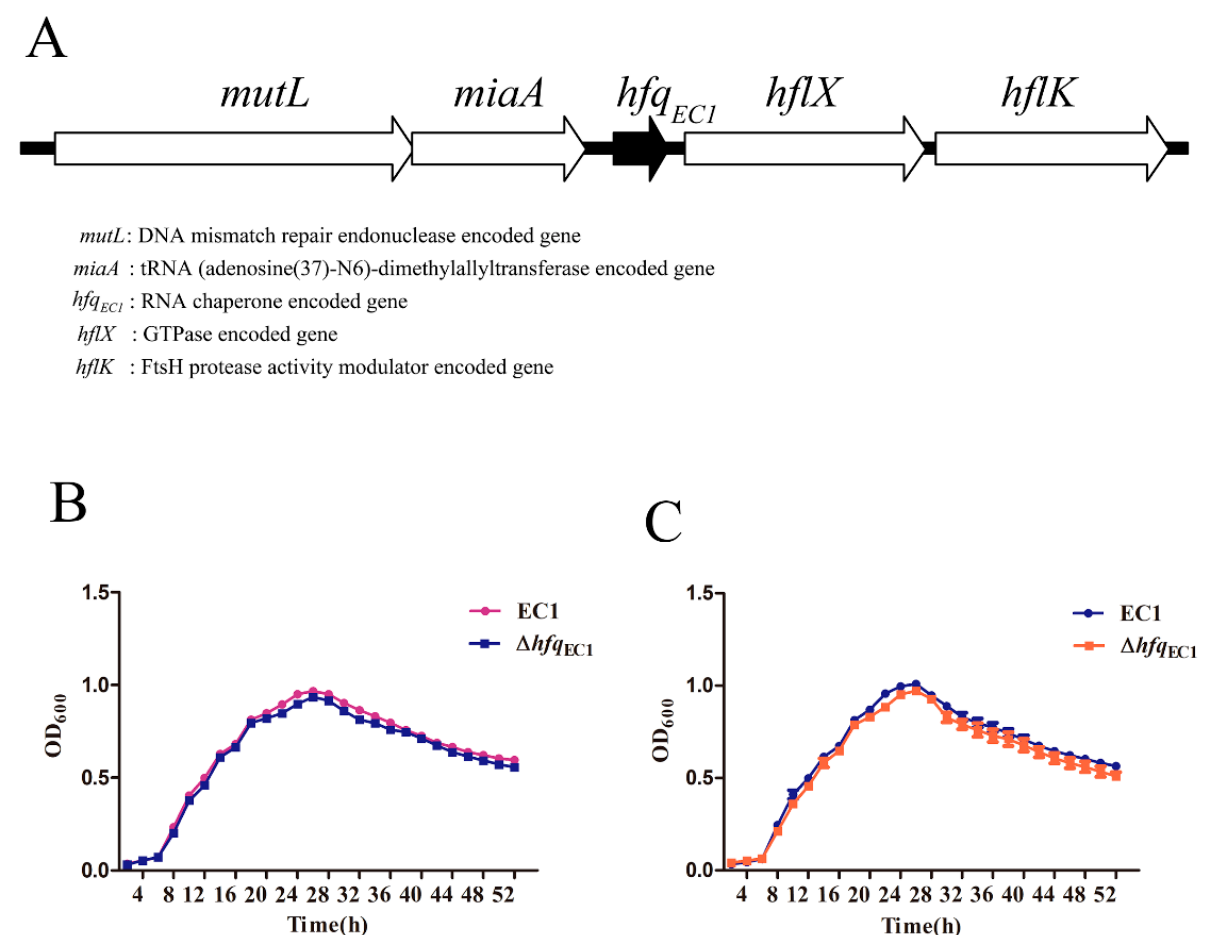
Figure 1. Gene organization of hfq EC1 and its influence on bacterial growth in Dickeya oryzae . ( A ) Gene organization of hfq EC1 . Growth patterns of the wild-type strain EC1 and the hfq EC1 deletion mutant were measured in Luria–Bertani (LB) medium ( B ) and minimal medium (MM) ( C ). 3.2. Deletion of Hfq EC1 Decreases the Production of Extracellular Degrading Enzymes in D. ory- zae EC1